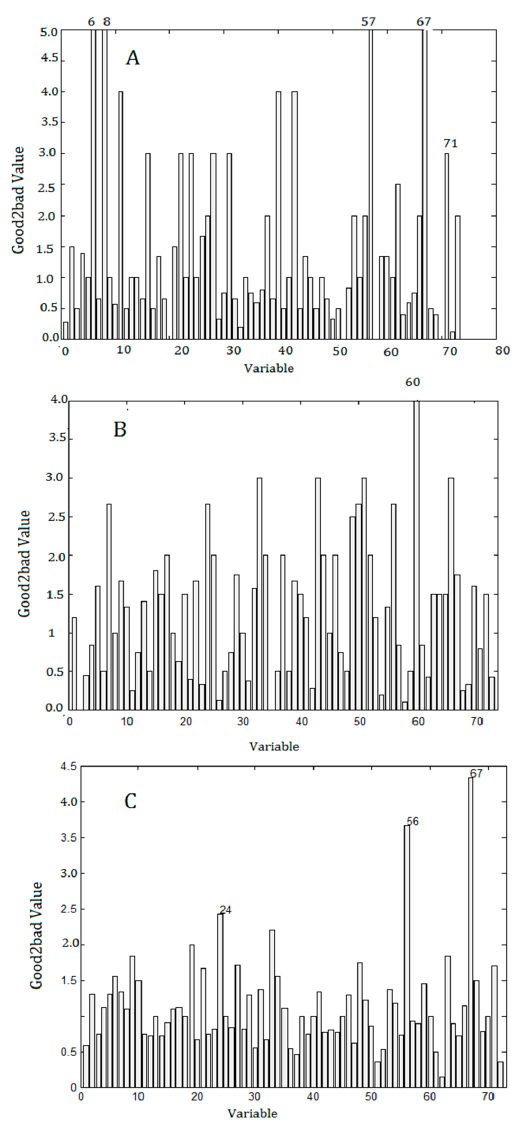
Figure 5. Good2bad values performed on the liquid chromatogram data through concentration additionmodel (CA, A ), response addition model (RA, B ) and the Olmstead model ( C ). Table 2. DAD and TIC data of selected compounds by different models.